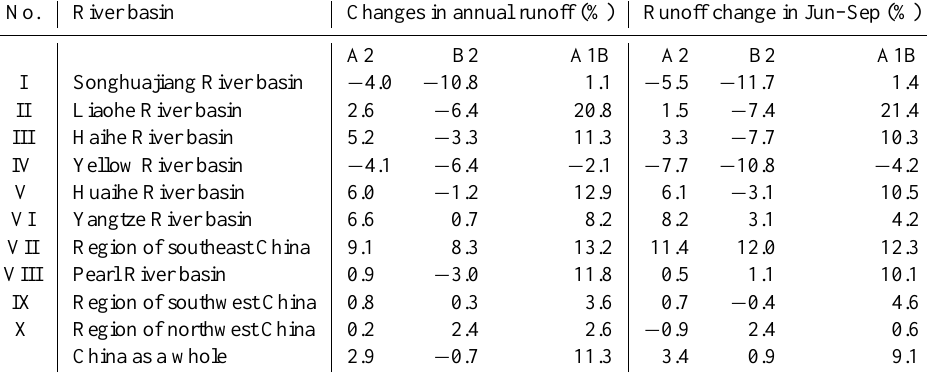
Table 4. Changes in runoff for 2021-2050 under scenarios A1B, A2 and B2. No. River